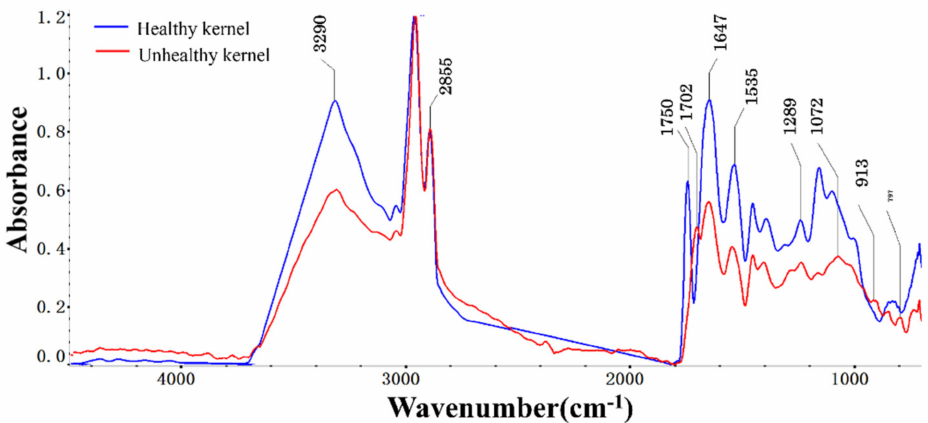
Figure 6. Infrared spectra of healthy and unhealthy peanut